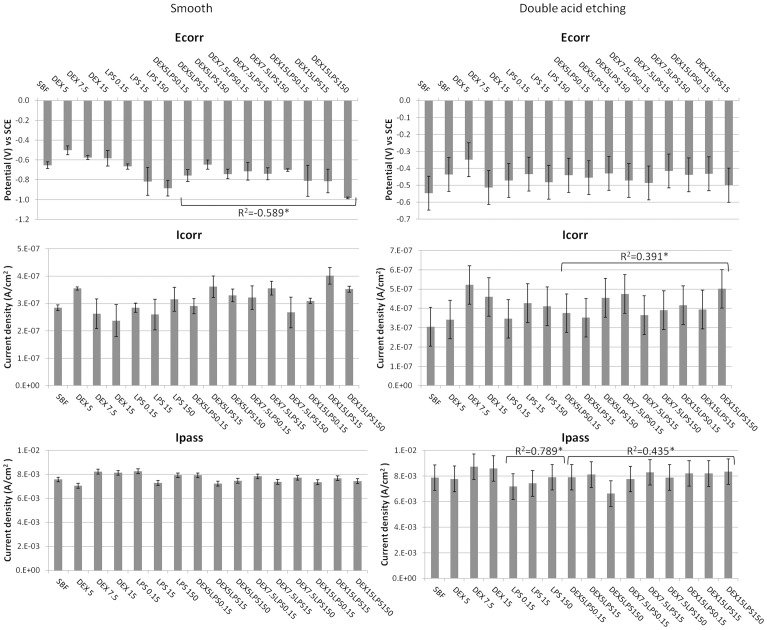
Electrochemical data of cyclic potentiodynamic polarization curve.Mean and standard deviation of corrosion potential (Ecorr), corrosion current density (Icorr), and the passivation current density (Ipass) for the Ti-6Al-4V alloys with a smooth surface and etched with acid, in SBF with different concentrations of dextrose (DEX) and lipopolysaccharide (LPS), alone or in combination (DEXLPS). * Denotes significant correlation at the 0.05 level.